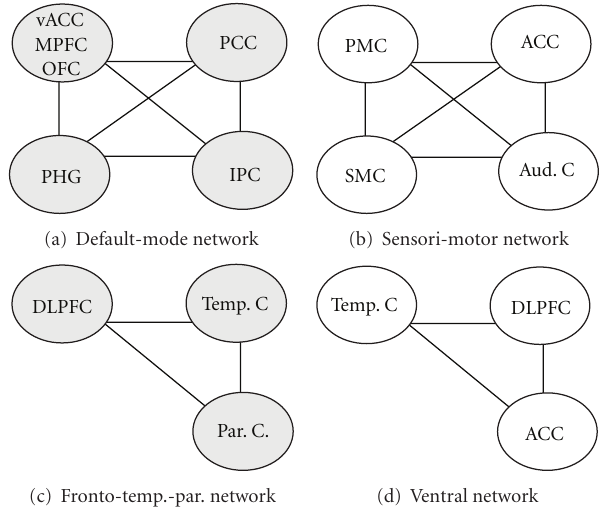
Figure 3: Schematic presentation of 4 reliable recovered networks, adapted from Kollewe and coworkers [69]. (a) Default - mode network : this network has been reviewed by Raichle and Snyder [65] who have described that activity in this network is high during rest and reduced during cognitive activity. It comprises a large frontal area, including ventral anterior cingulated cortex (vACC), medial prefrontal cortex (MPFC) and orbitofrontal cortex (OFC), the posterior cingulated cortex (PCC), the inferior parietal cortex (IPC), and a temporal region involving the parahippocampal gyrus (PHG). (b) Sensori-motor network : this network has been previously identified by a number of authors [62, 66–68]. This network comprises the primary motor cortex (PMC), premotor cortex (PMC), anterior section of cingulated cortex (ACC), the somatosensory region (SSC), and auditory cortex (Aud. C). (c) Fronto-temporo-parietal network : this network includes prefrontal (BA9, BA10, BA11), temporal (BA20, BA27), and parietal (BA7, BA39, BA40) regions. (d) Ventral network : this network comprises the middle temporal gyrus (Temp. C, BA21), parts of the frontal cortex (DLPFC, BA9, BA47), and parts of the cingulated gyrus (ACC, BA31, BA24). The posterior network is not shown; it comprises mainly visual areas in the occipital cortex including BA18 and BA19.